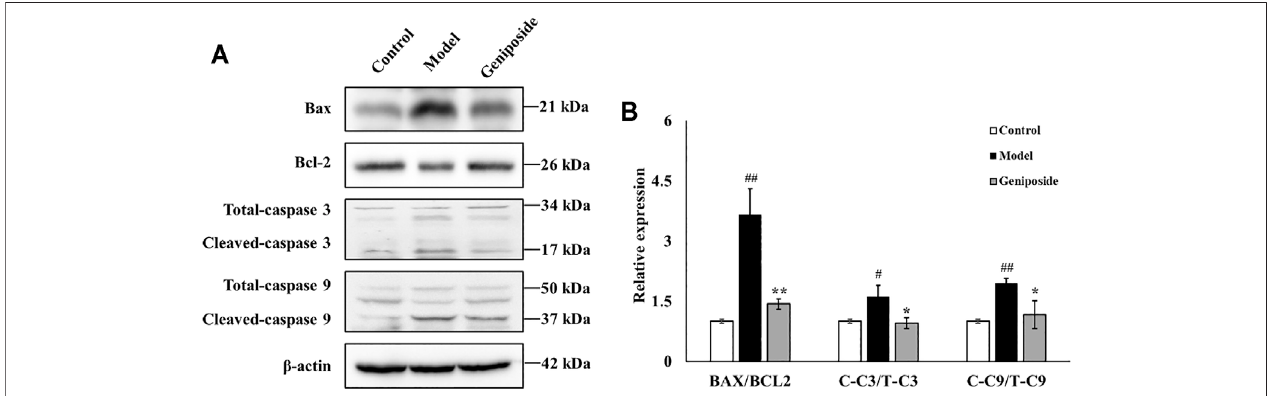
FIGURE 6 | Geniposide treatment regulated BAX, Bcl-2, Caspase 3, and Caspase 9 in liver fi brosis model mice. (A,B) Changes of the protein expression of BAX, Bcl-2, Caspase 3, Caspase 9, and β -actin in liver tissue. Geniposide treatment reversed the relative expression of the BAX, Bcl-2, Caspase 3, and Caspase 9 in model mice liver tissue. Control, model, and geniposide groups ( n (cid:2) 3 per group). # p < 0.05, Model group vs. Control group; ## p < 0.01, Model group vs. Control group; p p < 0.05 and pp p < 0.01, Geniposide group vs. Model group.